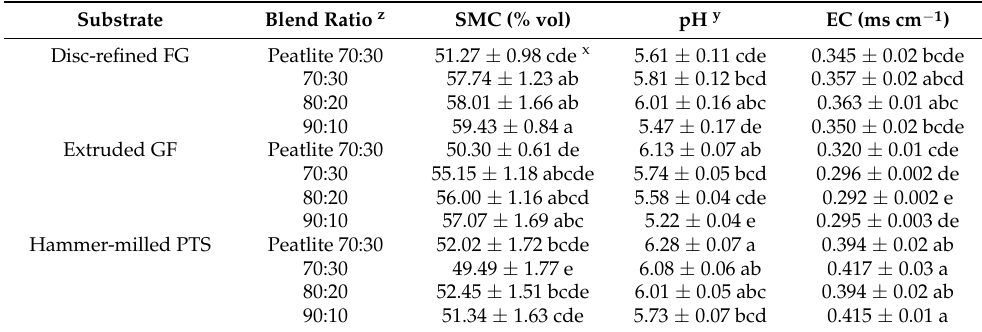
Table 2. Mean substrate moisture content (SMC), pH, and electrical conductivity (EC) of the substrate treatments ± standard error for objective two.